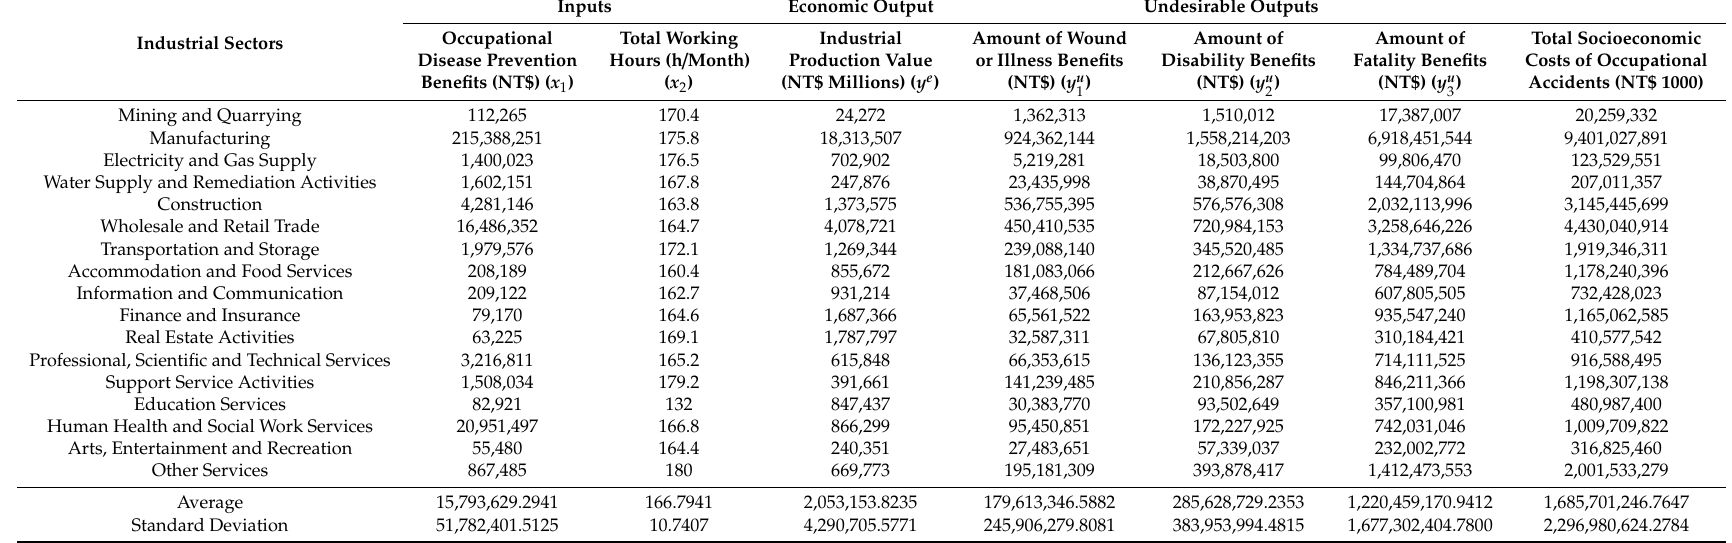
Table 1. Relative input and output data from 17 industrial sectors in